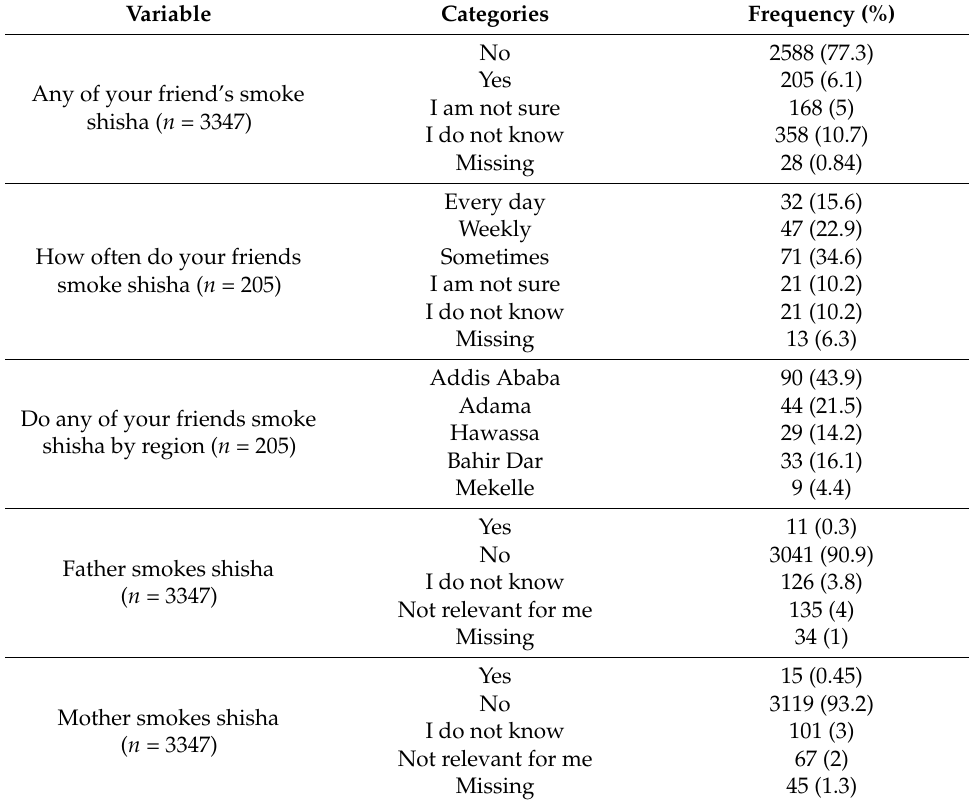
Table 3. High school students’ parents and friends’ shisha-smoking experience in Ethiopia (March 2020).